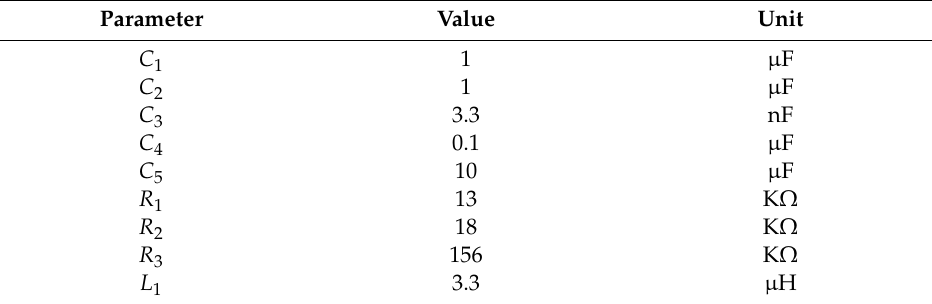
Table 9. Relevant parameters of the DC/DC conversion circuit.